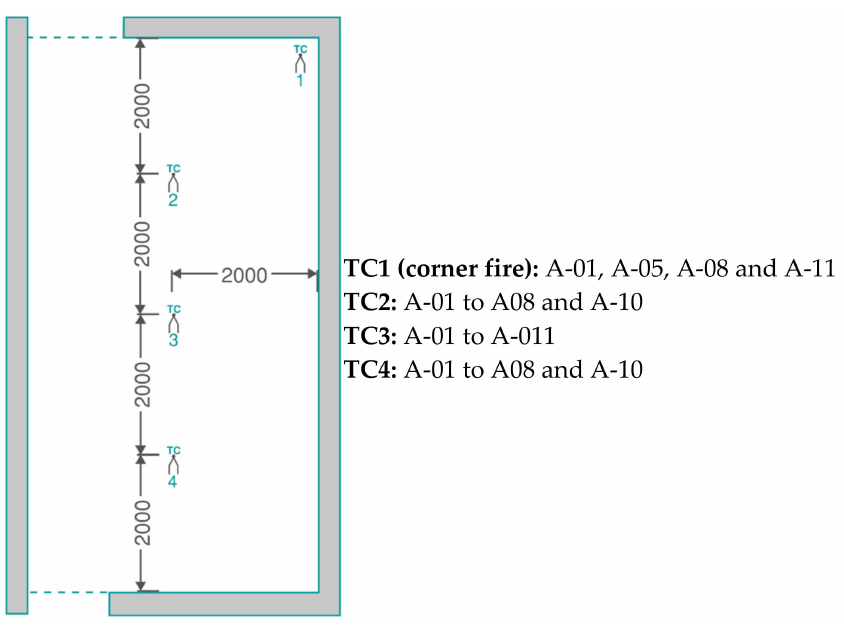
Figure 5. Test thermocouple locations. All dimensions in mm.